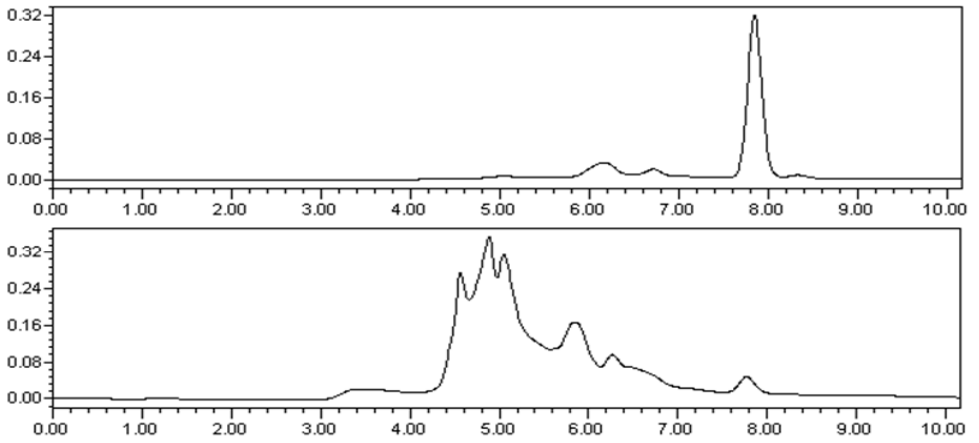
Figure 4. ( A ) HPLC analysis of compound 2 (retention time: 7.848 min); ( B ): HPLC analysis of the MeOH extracts of L. casuarinoides (retention time: 7.821 min). HPLC analyses were performed on Waters 1525-2998 series HPLC system (C-18 column, Sun Fire, 5 μ m, 4.6 mm × 150 mm); mobile phase, CH injection volume, 10 μ